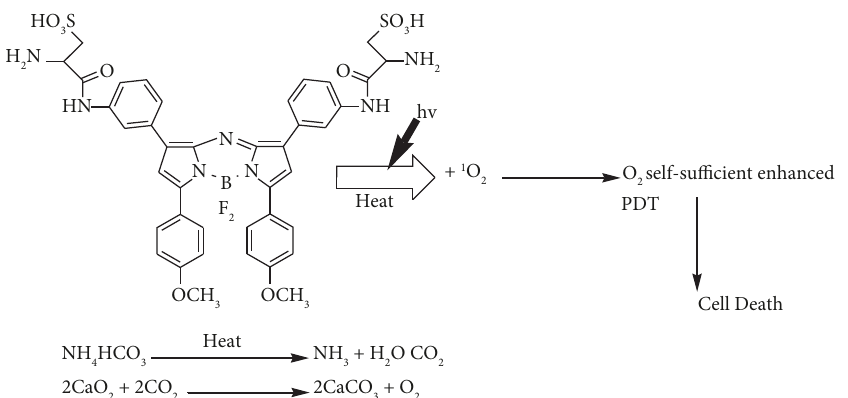
Figure 10: Two-stage mechanism of CaO 2 and boron aza BODIPY photodynamic therapy.